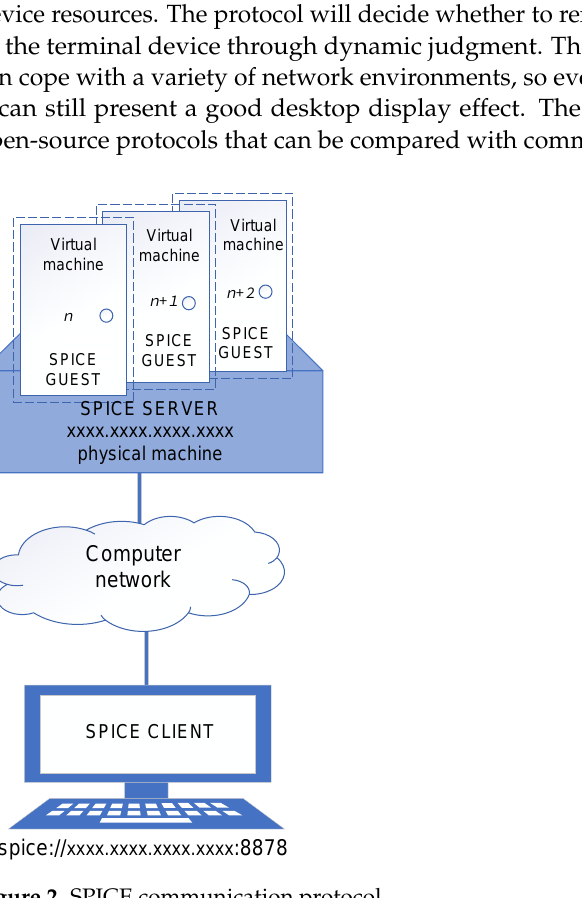
Figure 2. SPICE communication